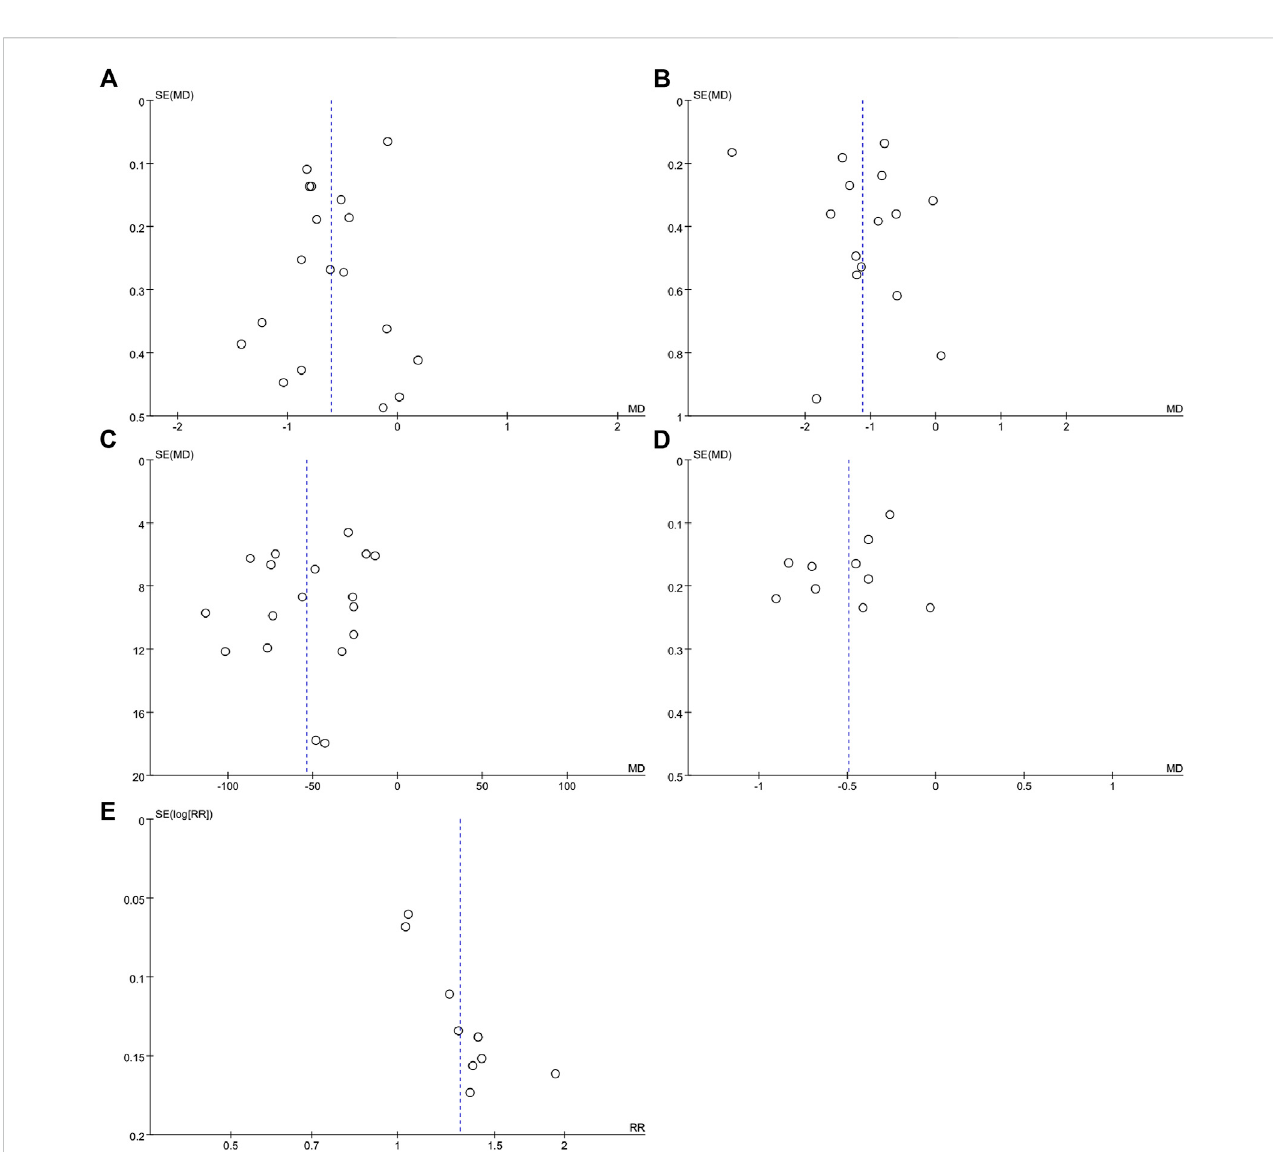
FIGURE 8 Funnel plots for assessing publication bias. (A) FBG (B) 2hPG (C) UA (D) TC; and (E) overall effective rate.